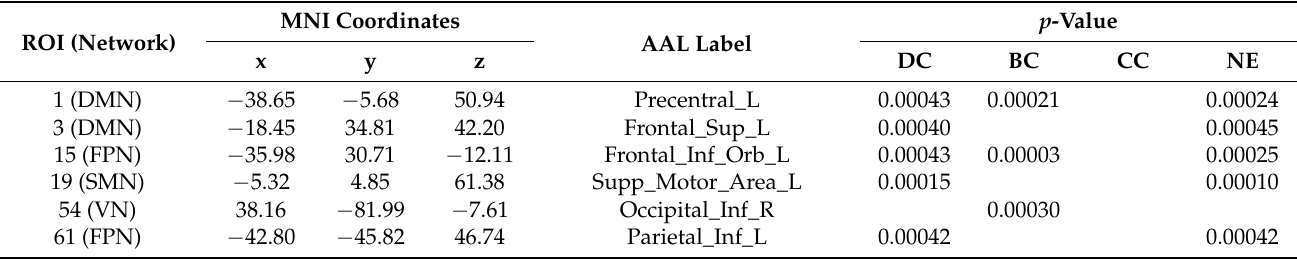
Figure 3. Area under the curve in the morning session (blue) and the evening session (gray) for degree centrality ( A ) and betweenness centrality ( B ) of all 116 brain regions. Significant diurnal fluctuations are represented by red lines. See Table A1 for the description of the areas. Table 2. List of brain regions of interest (ROIs) that changed throughout the day (significance level was set at p < 0.01 and p -values were adjusted for the Bonferroni